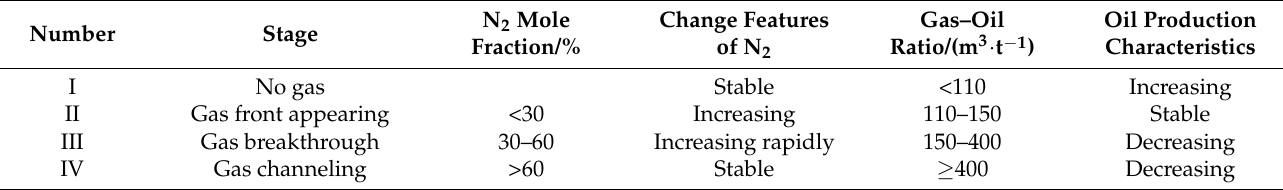
Figure 6. Saturation field of N 2 content. Table 3. Classification standard of gas channeling in the FAORAF stage.